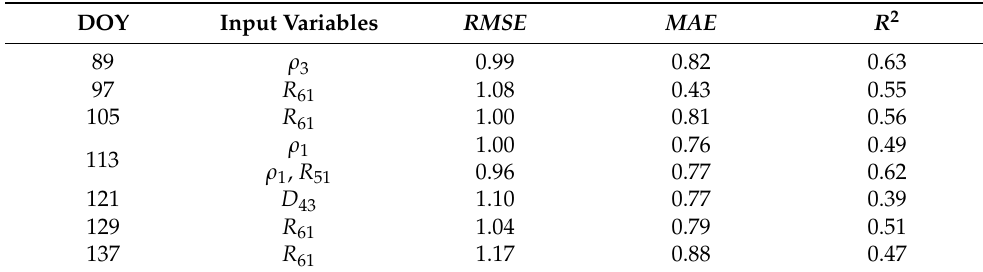
Table 6. Results of SOM prediction using the total dataset based on 7